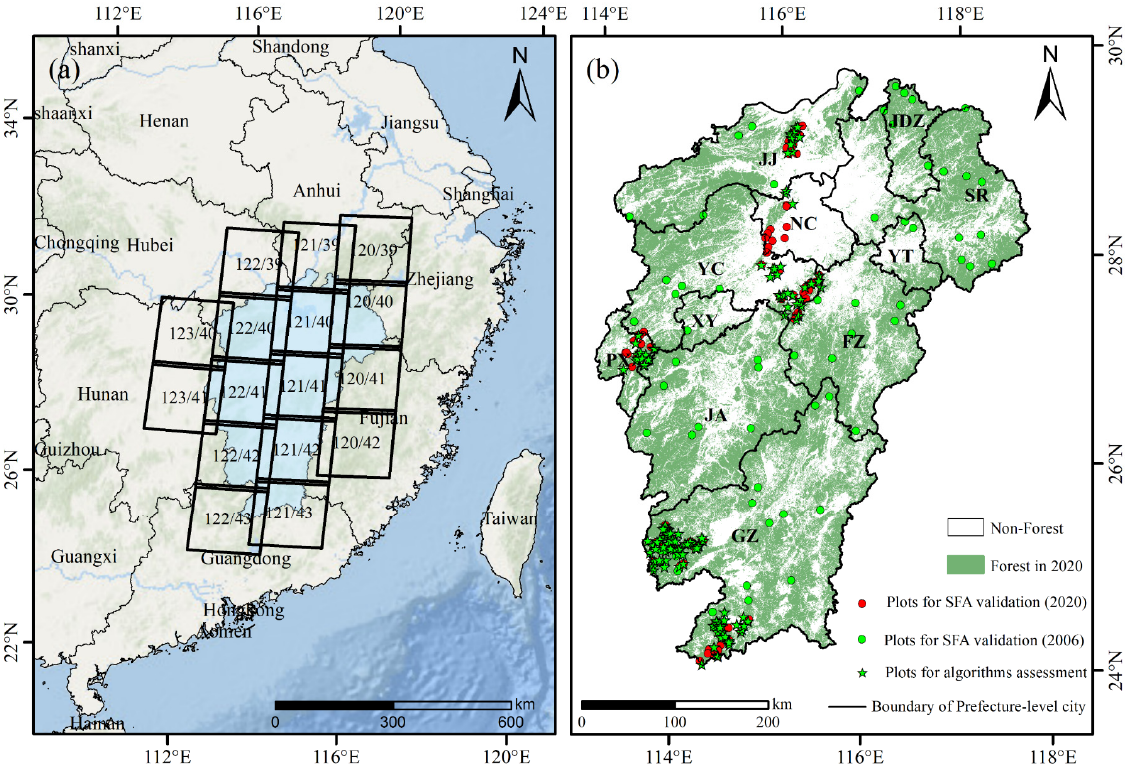
Figure 1. Map of the study area. ( a ) The location of Jiangxi province in China and its corresponding Landsat scenes (black rectangles). ( b ) The new reference forest map of Jiangxi province in 2020 (described in Section 2.2.3) and the forest samples (described in Section 2.2.2).